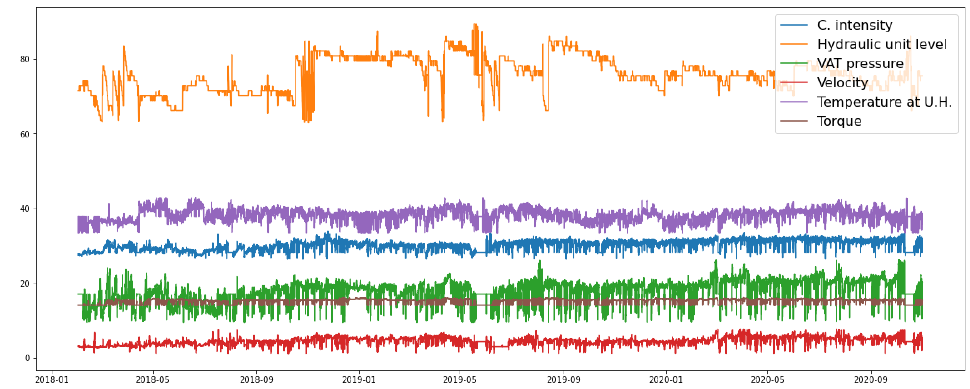
Figure 5. Sensor variables after applying data cleaning treatment. Many extreme values were removed.